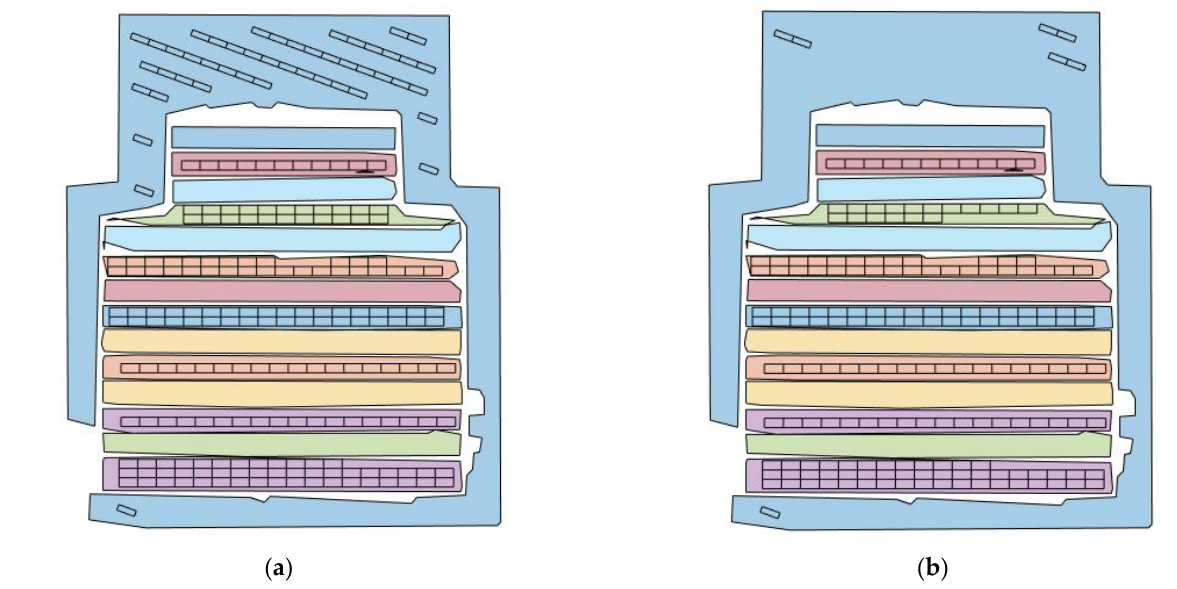
Figure 18. Comparison of PV module layout for the CAM building ( a ) without and ( b ) with shading analysis.